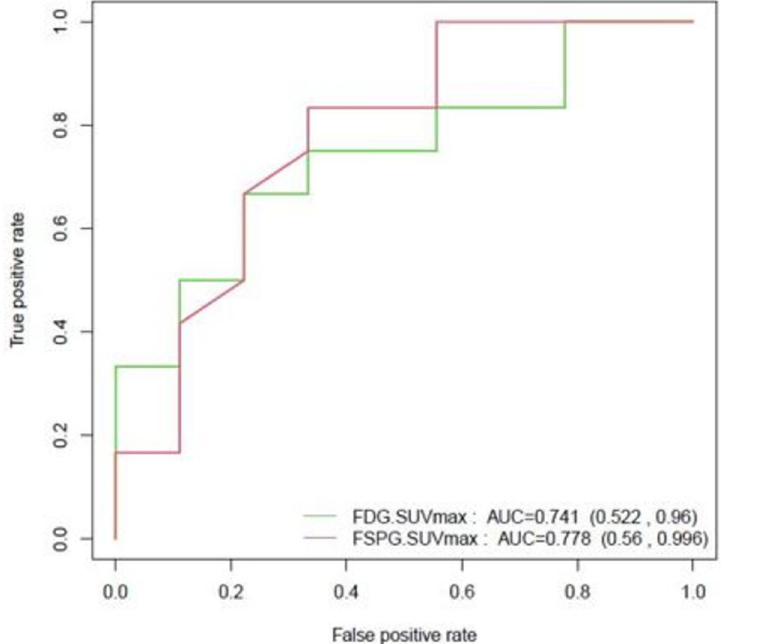
Fig 1. 18 F-FSPG and 18 F-FDG ROC curves for IPNs (N = 21).